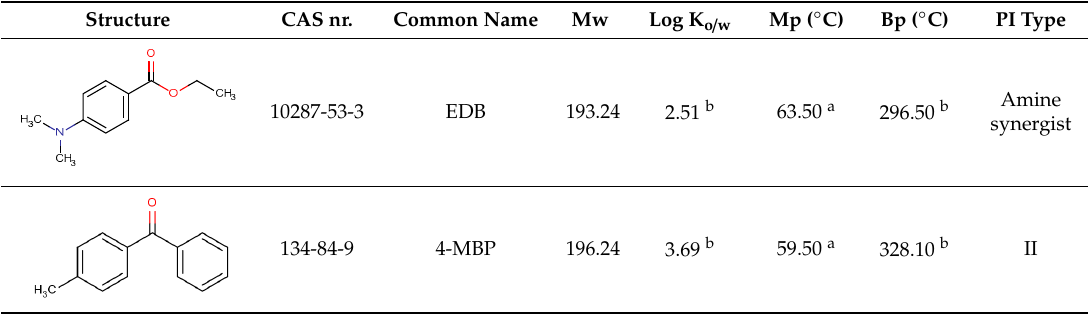
Table 3. Summary of the main properties of 4-methyl benzophenone (4-MBP) and ethyl-4-